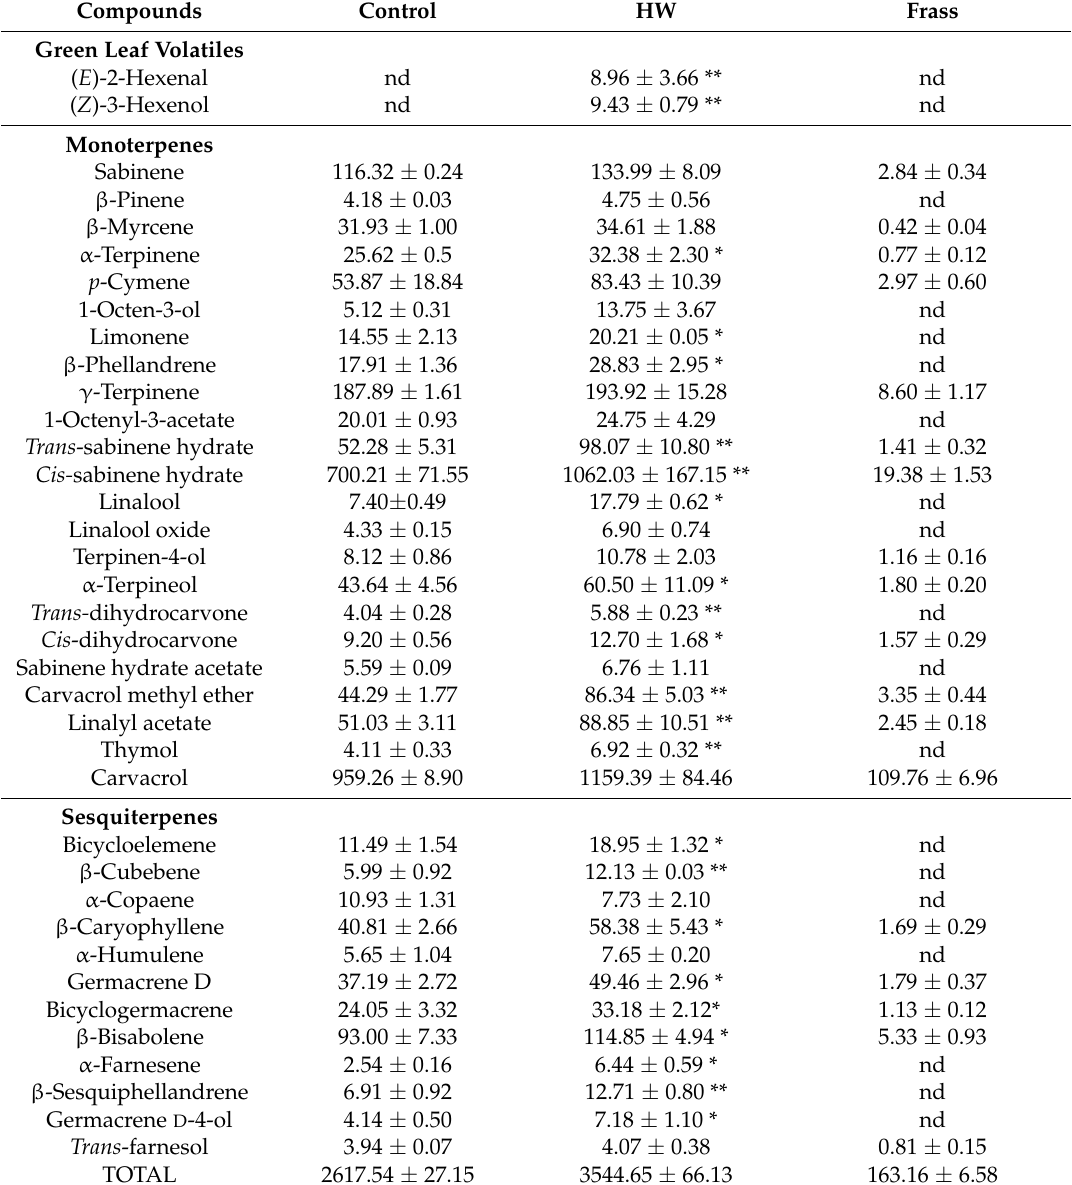
Table 1. Chemical composition of Origanum vulgare terpenoids in undamaged control plants, in Spodoptera littoralis herbivore wounded (HW) plants and in S. littoralis frass upon feeding on O. vulgare leaves. The results are expressed as µ g g − 1 fresh weight and are the mean of at least three replicates ± SD. Asterisks indicate significant differences between control and HW: * p < 0.05; ** p <